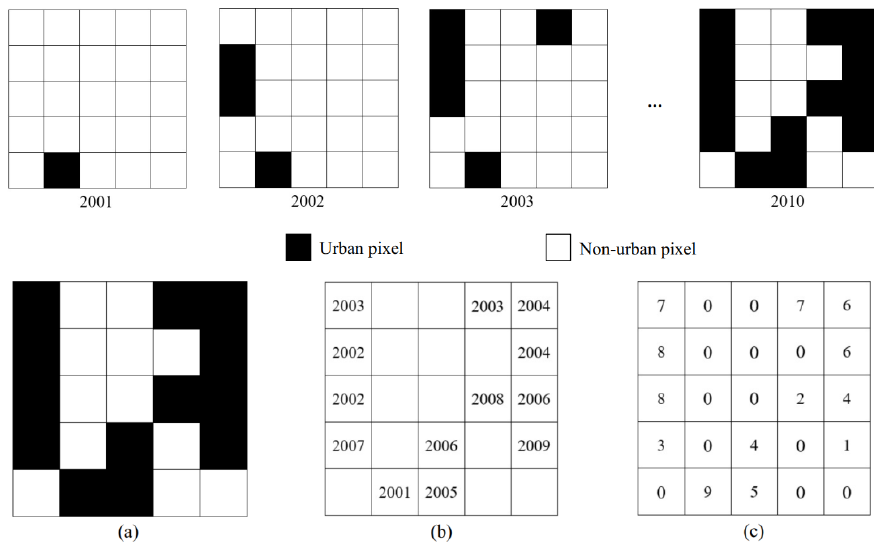
Figure 3. Generation of continuation period layer, with the start year of 2001 and the end year of 2010. Pixels that have been urbanized are blackened, un-urbanized pixels stay white: ( a ) subset of a raster binary image of the urban extent in 2010; ( b ) the year of urbanization t u is derived from each pixel; ( c ) the difference between the end year and the year of urbanization depicts the continuation period.